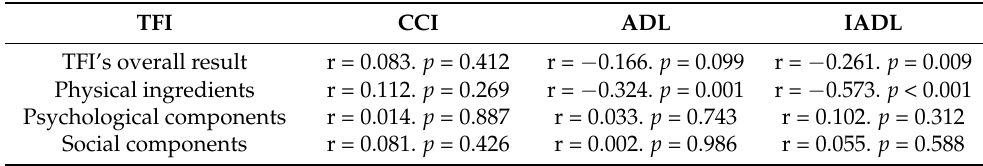
Table 2. Coefficient of correlation between the frailty score (TFI) and the Charlson Coexistence Index (CCI), the Katz score (ADL) and the Lawton score (IADL). TFI CCI ADL IADL TFI’s overall result r = 0.083. p = 0.412 r = − 0.166. p = 0.099 r = − 0.261. p = 0.009 Physical ingredients r = 0.112. p = 0.269 r = − 0.324. p = 0.001 r = − 0.573. p < 0.001 Psychological components r = 0.014. p = 0.887 r = 0.033. p = 0.743 r = 0.102. p = 0.312 Social components r = 0.081. p = 0.426